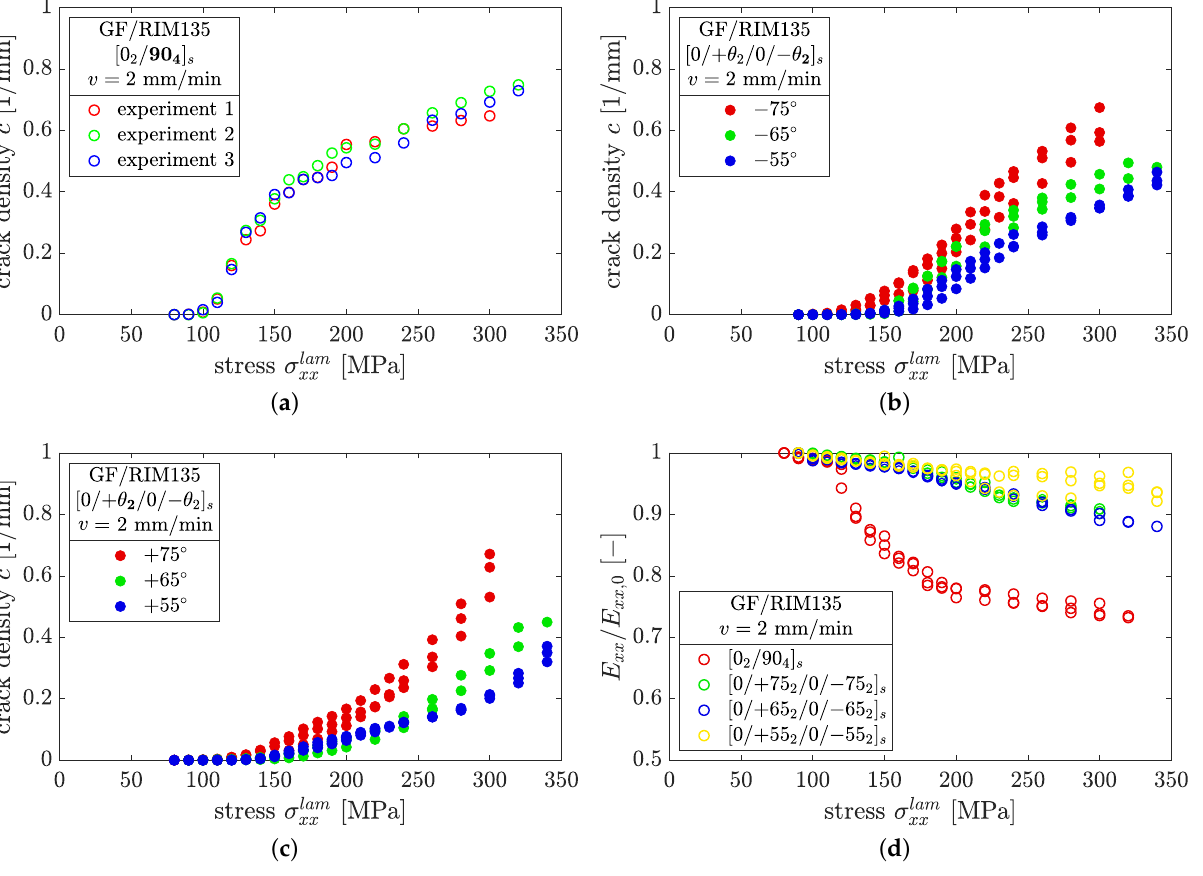
Figure 8. Results of crack density formation in ( a ) [ 0 2 /90 4 ] s laminates, ( b ) the thick layers, and ( c ) the thin layers of angle-ply laminates; ( d ) shows the corresponding stiffness reduction for all laminates under static